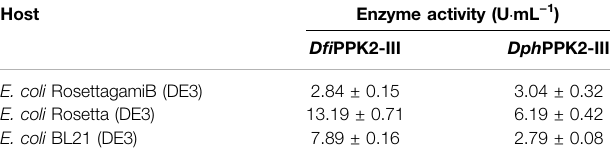
TABLE 4 | Enzyme activity of PPK2-III in different hosts.